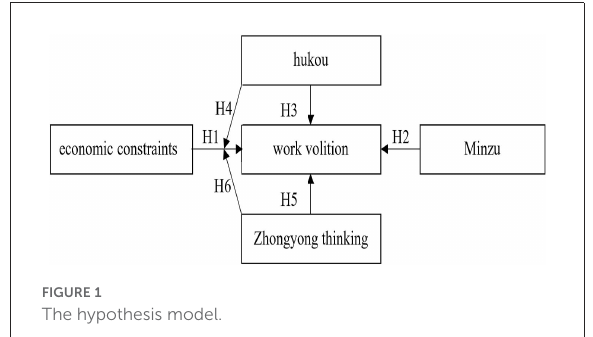
FIGURE1 The hypothesis model.